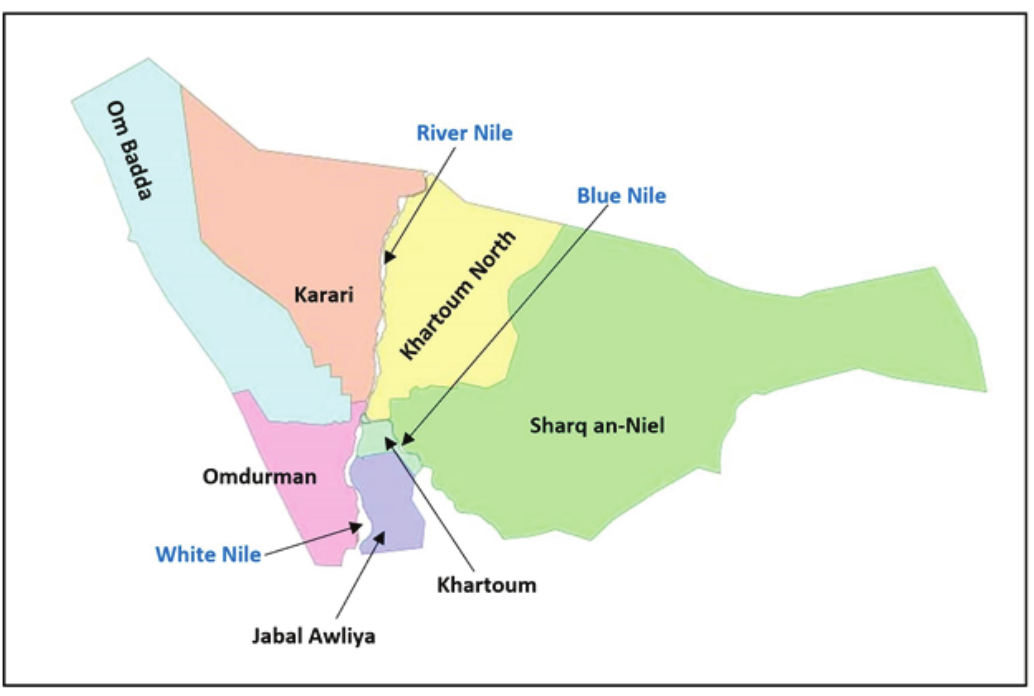
Figure 1: Khartoum state – seven